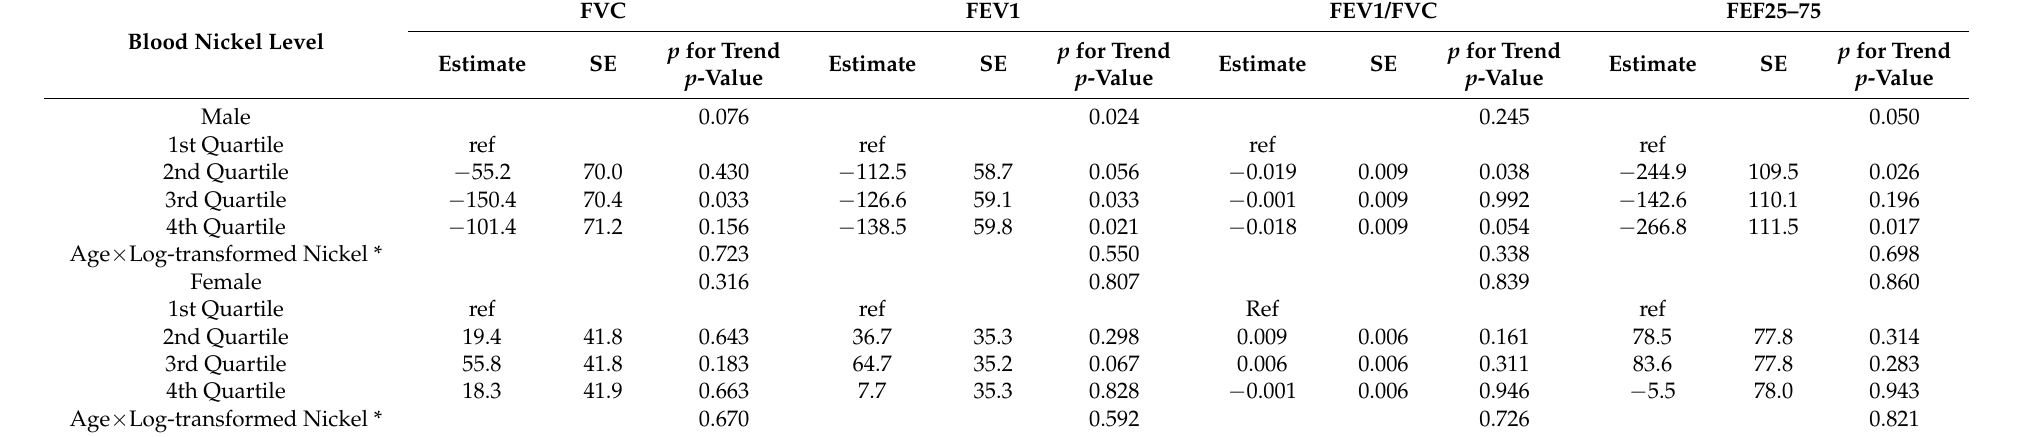
Table 4. Multivariate analysis of the effects of blood nickel quartiles on pulmonary function components by